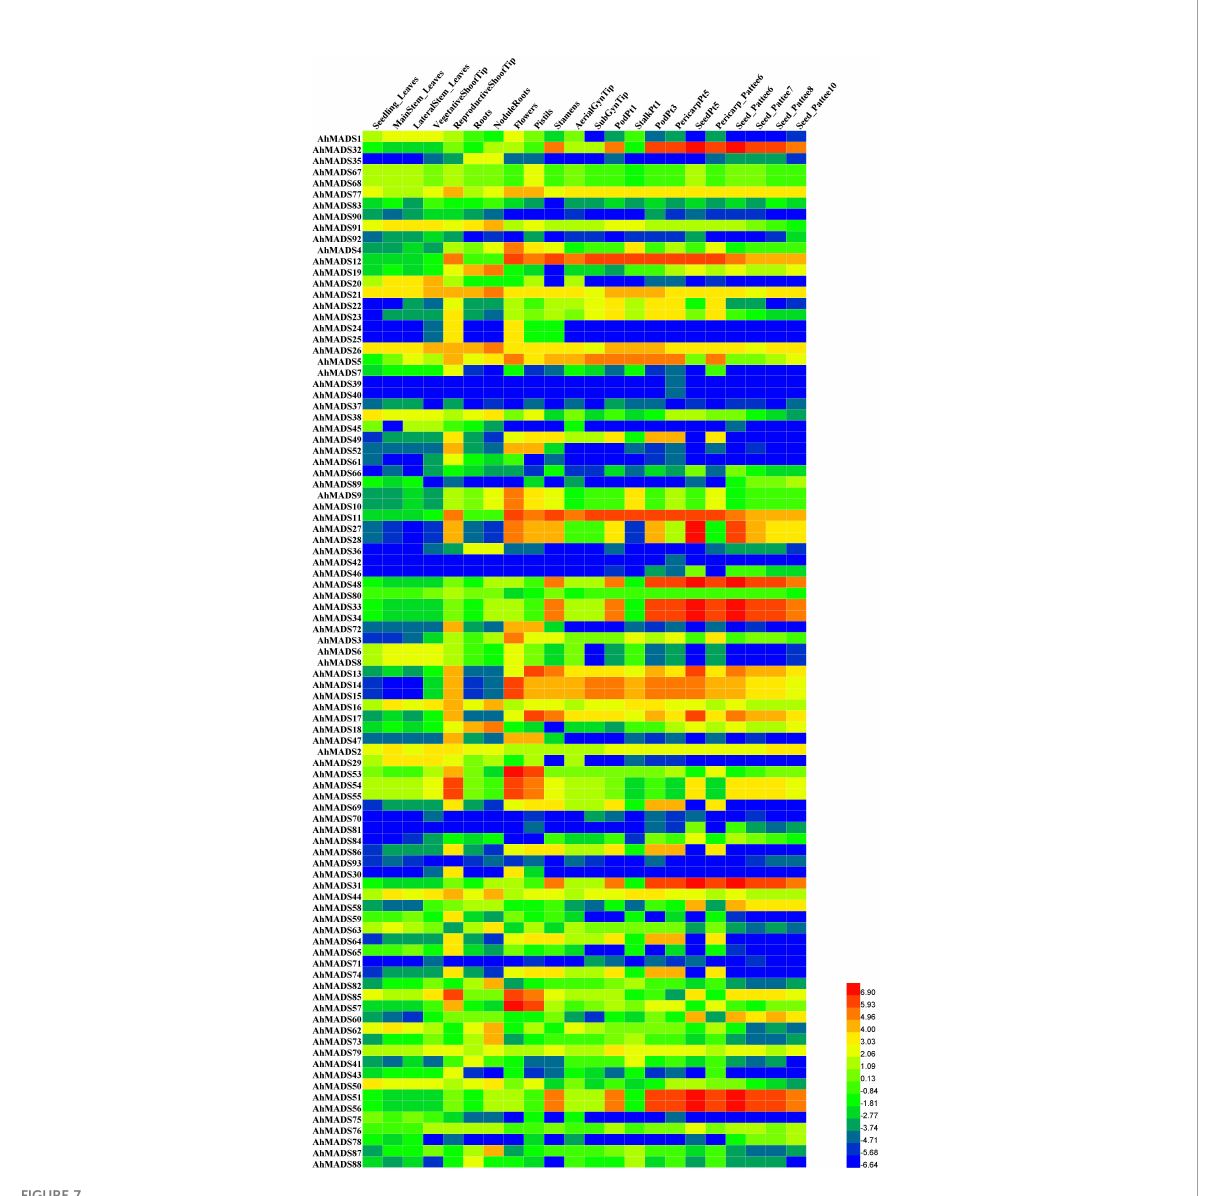
FIGURE 7 Expression pro fi les of MIKC-type MADS-box genes in 22 different peanut tissues. The heatmap was generated by Heml software, and the fragments per kilobase of transcript per million fragments (FPKM) values of peanut MADS-box genes were log2-transformed. The red and blue colors represent the maximum and minimum values,